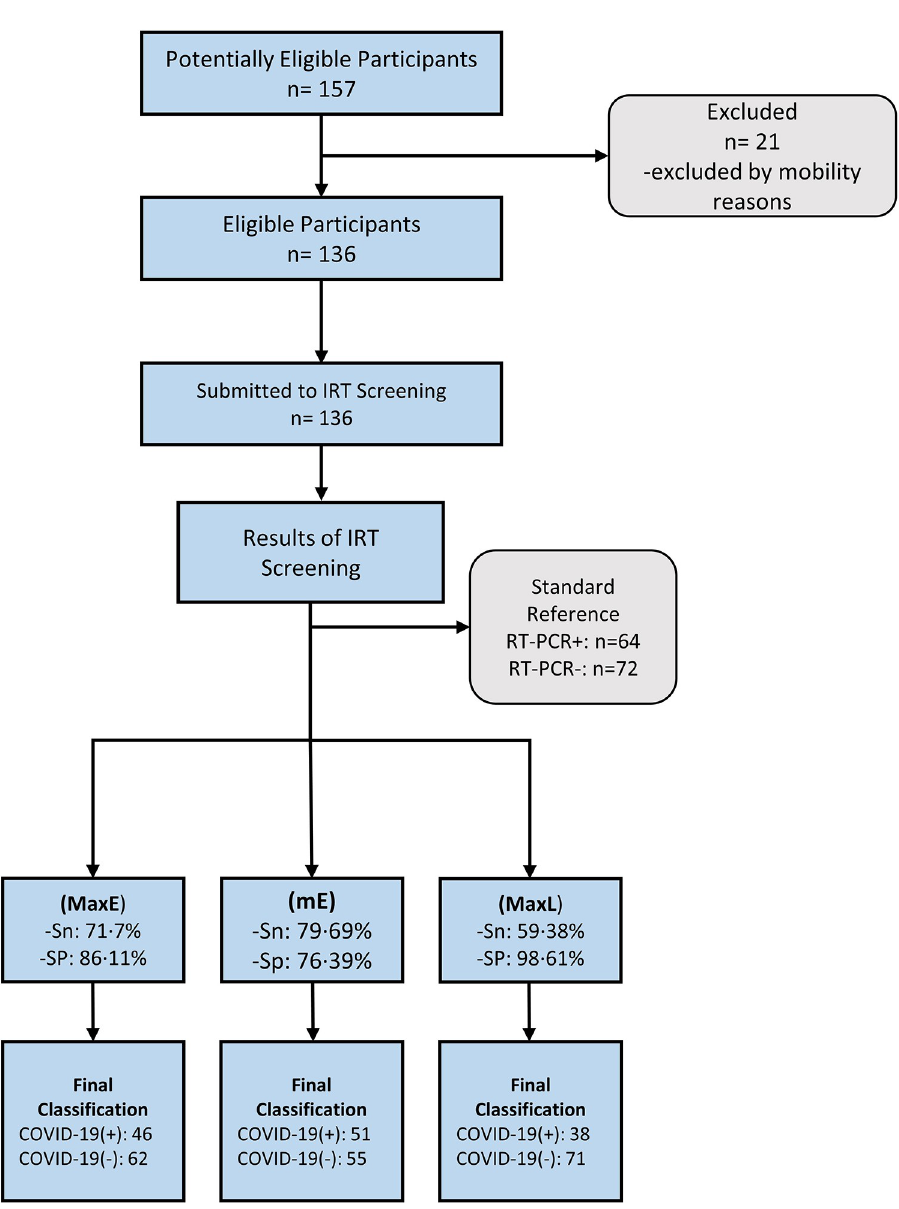
Fig 1. Flow chart diagram of the study design. Best infrared parameters: MaxE (maximum temperature of the Eyes); mE (mean temperature between the eyes); MaxL (maximum temperature of the lateral of the nose).